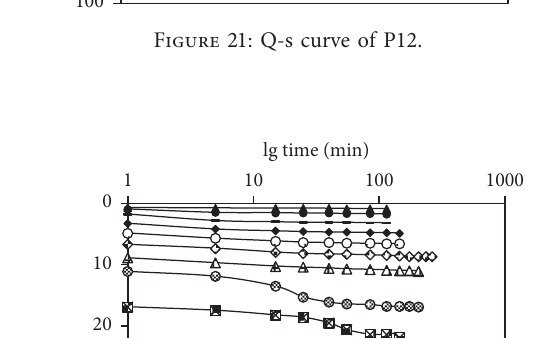
Figure 21: Q-s curve of P12.